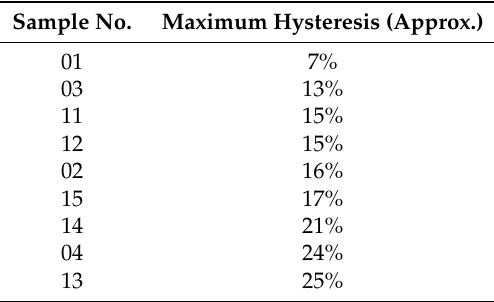
Table 5. Maximum hysteresis error of the